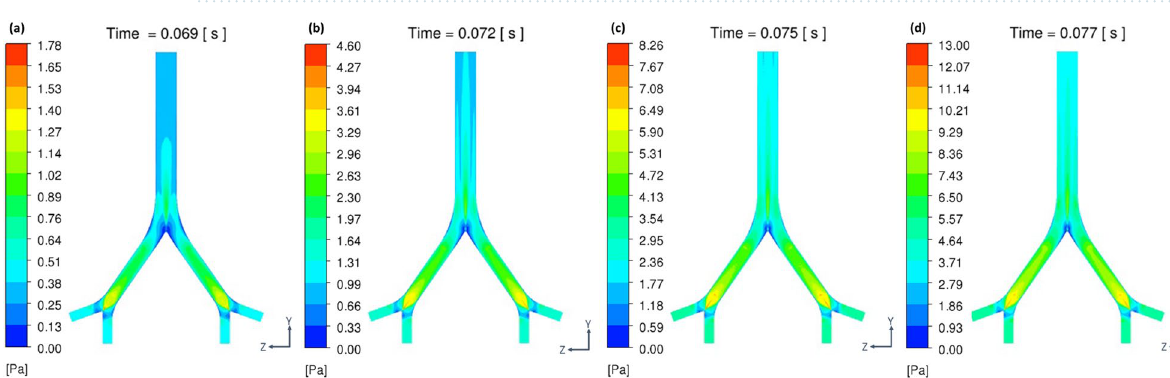
Figure 4. WSS contour on the airway surface at PVT.